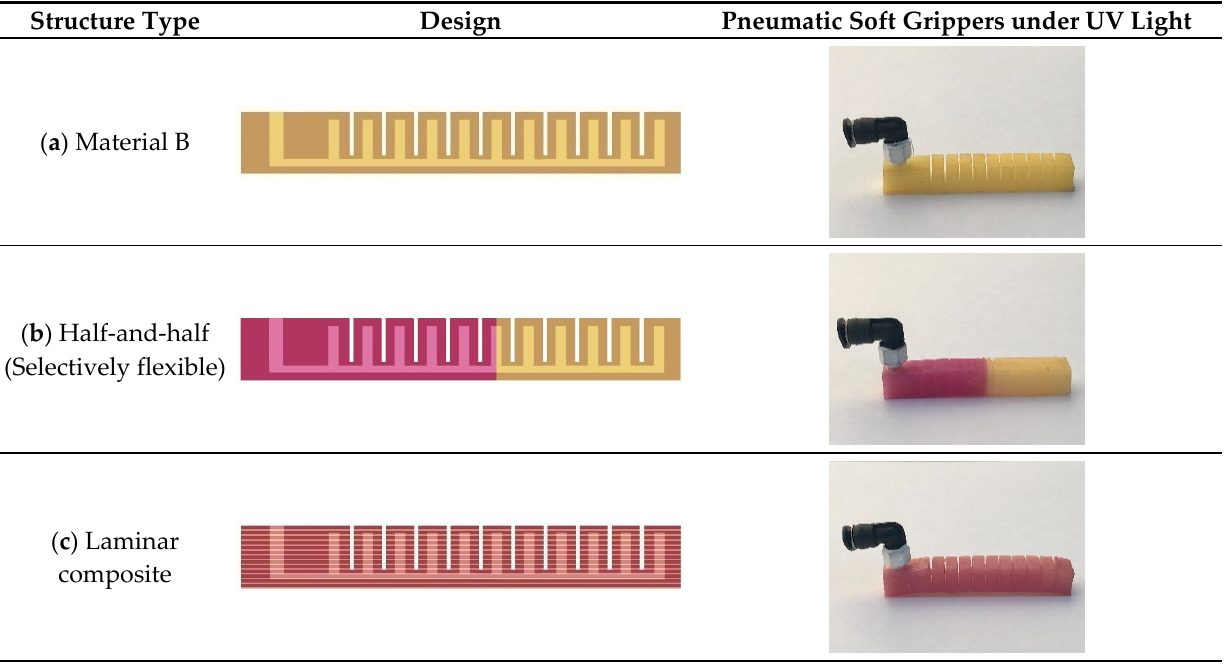
Figure 17. Soft gripper specimens involved in the pneumatic test.